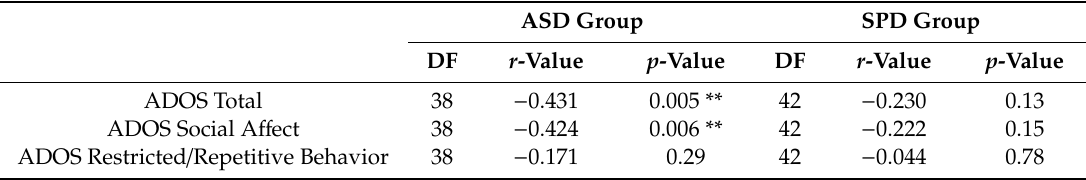
Table 5. Correlations between UPSIT and ADOS Scores a .